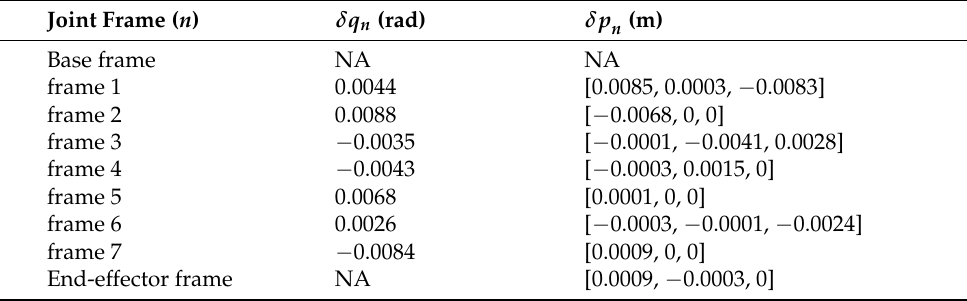
Figure 2. Commanded robot joint motion to generate the training dataset. ( a ) Joint 1. ( b ) Joint 2. ( c ) Joint 3. ( d ) Joint 4. ( e ) Joint 5. ( f ) Joint 6. ( g ) Joint 7. Table 3. Calibration parameters for Model